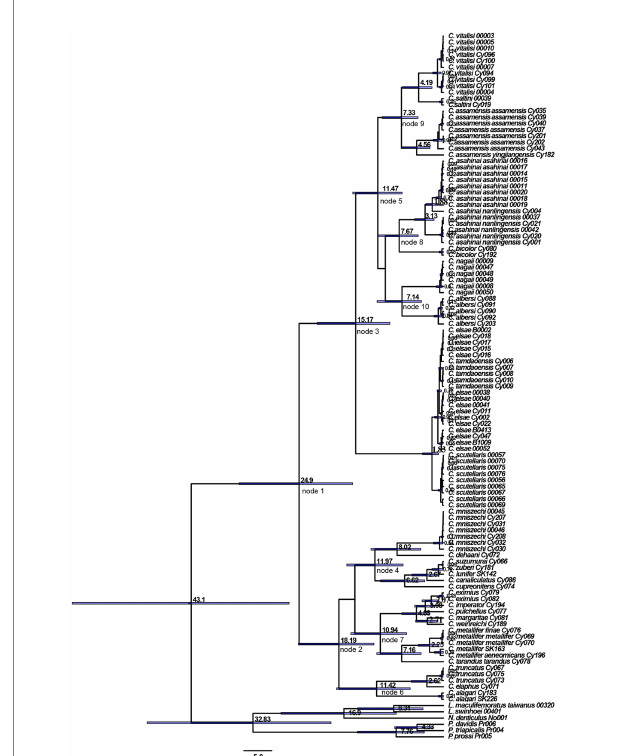
FIGURE 3 Divergence time estimation of Cyclommatus stag beetles based on COI and 16S rDNA gene. Divergence time estimates are represented next to the nodes (in millions of years) with horizontal bars indicating 95% highest posterior density intervals.